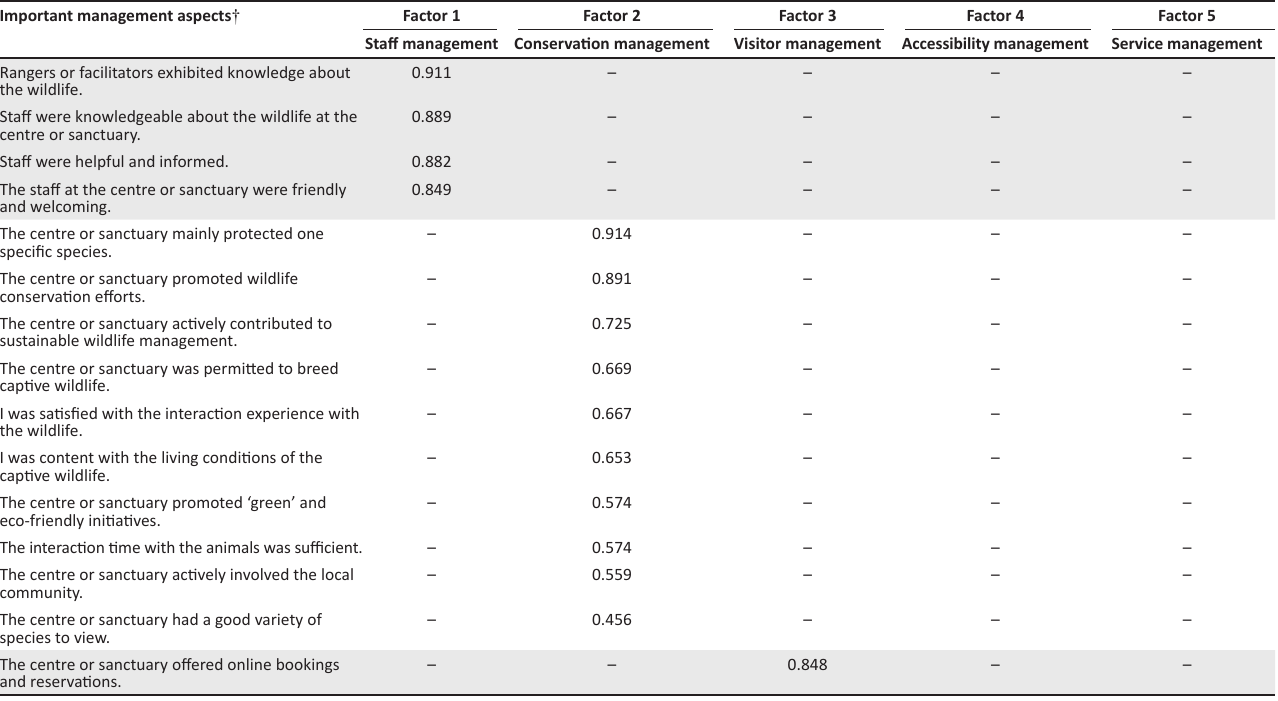
TABLE 3: Results of the exploratory factor analyses on the visitor experience management